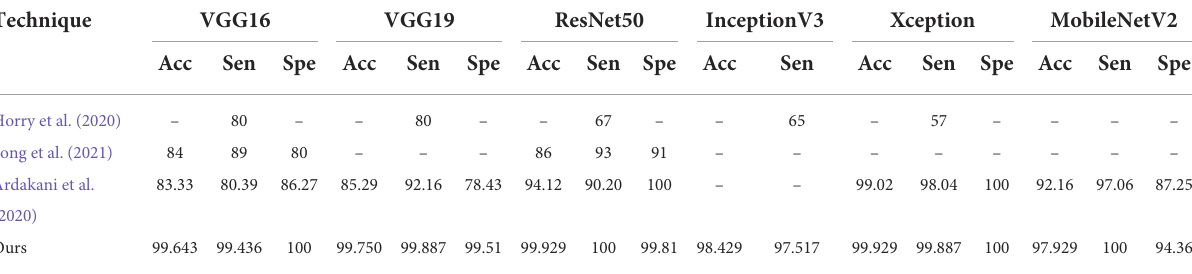
TABLE 8 Comparison with other techniques.